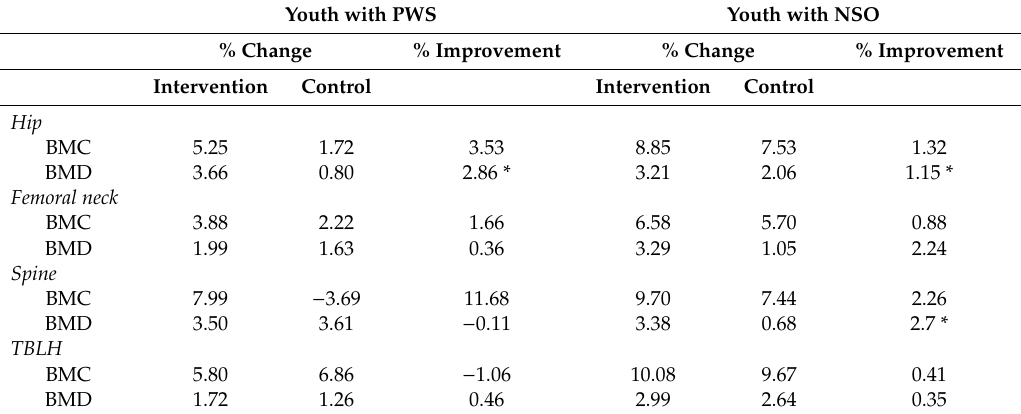
Table 3. Bone parameters percent change (%) as well as percent improvement (%) of the intervention over the control group presented by youth